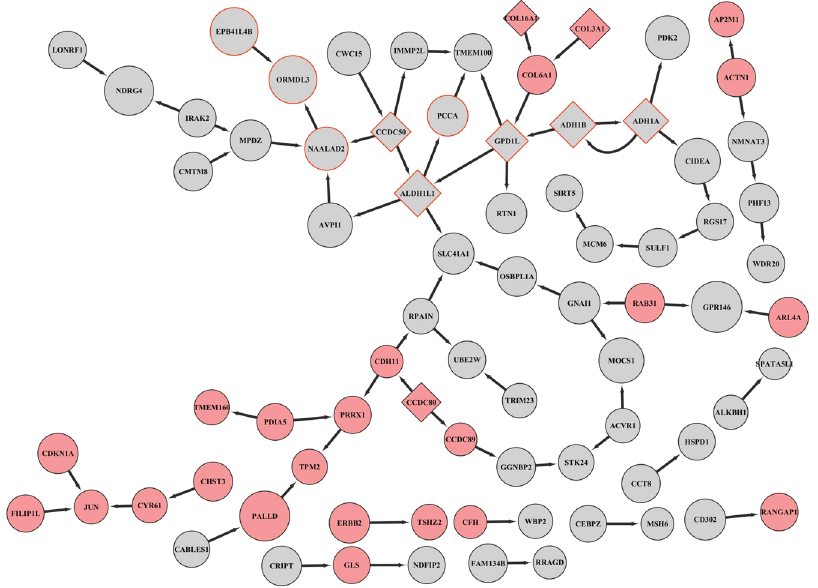
Figure 3. Causal network structure of the Yellow module. Each node represented a gene and each directed edge indicated a causal link between genes. Key driver genes were represented by diamond nodes. Node sizes were proportional to − log10 (GS p-value) of each gene. All hub genes’ borders were in red. Node color was shown in red and grey, where grey color was indicative of an upregulation in obese subjects, and red color an upregulation in non-obese subjects.